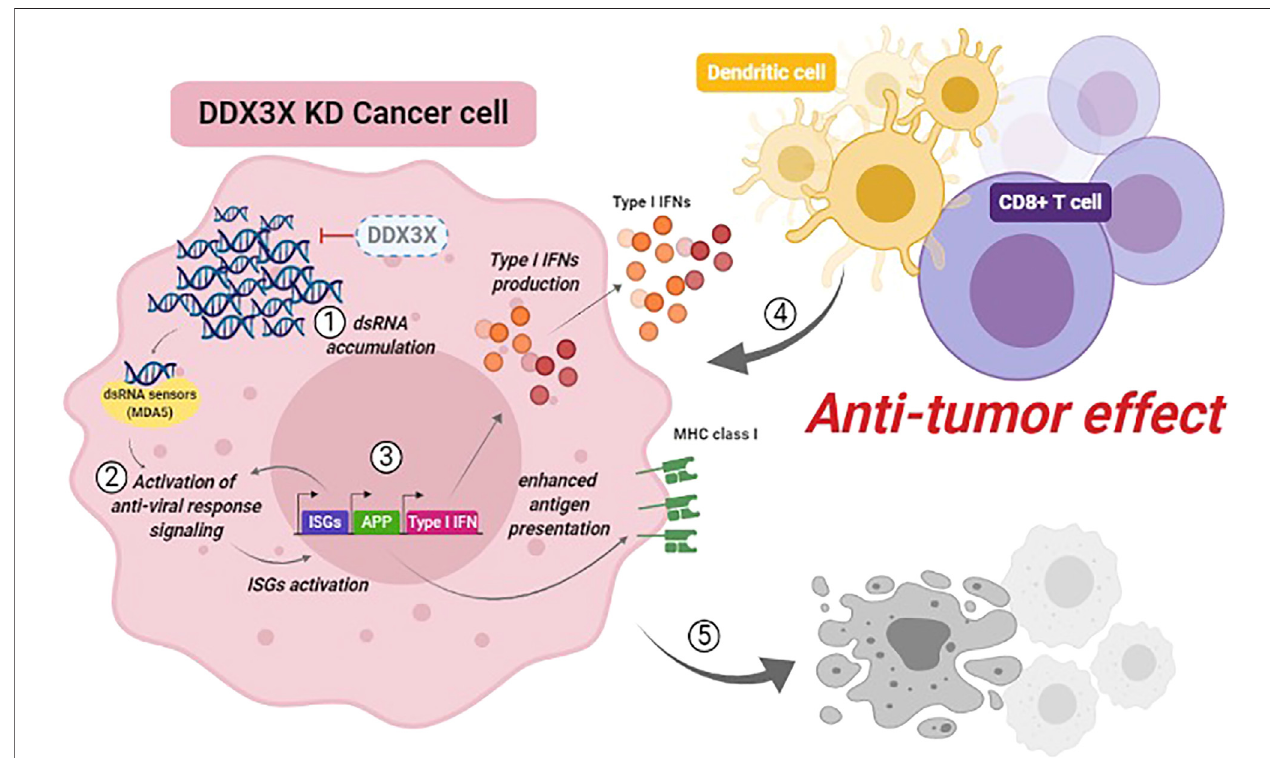
FIGURE 1 | Increased endogenous dsRNA stress by targeting DDX3X in cancer. Inhibiting DDX3X leads to cytosolic accumulation of endogenous dsRNAs. Increased cellular endogenous dsRNA stress triggers cancer cell-intrinsic antiviral response via dsRNA-sensing pathway. Targeting DDX3X could enhance cancer cell- intrinsic innate immune response and boost anti-tumor immunity, suppressing tumor growth and